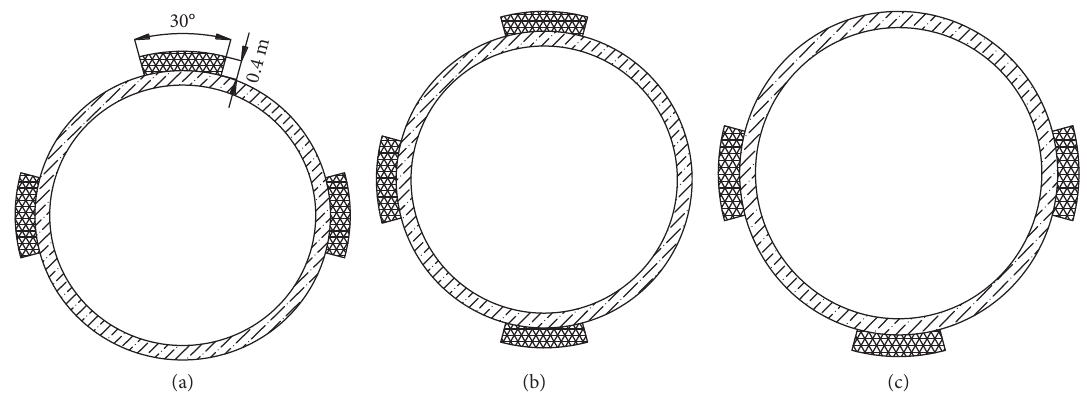
Figure 28: Combined working conditions of three cavities. (a) Double-sided arch waist and behind the arch roof cavity. (b) Arch roof, arch waist, and behind the arch bottom cavity. (c) Double-side arch waist and behind the arch bottom cavity.